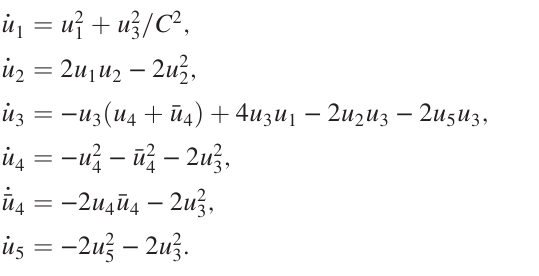
FIG. 4. The solution of the RG equations, Eq. (23), for the model where the electron pockets have d RG equations and the fixed trajectory are the same as in the model =d with d electron pockets; however, initial values of the xz yz couplings are different. The convergence towards the fixed trajectory is much better than in the model with d